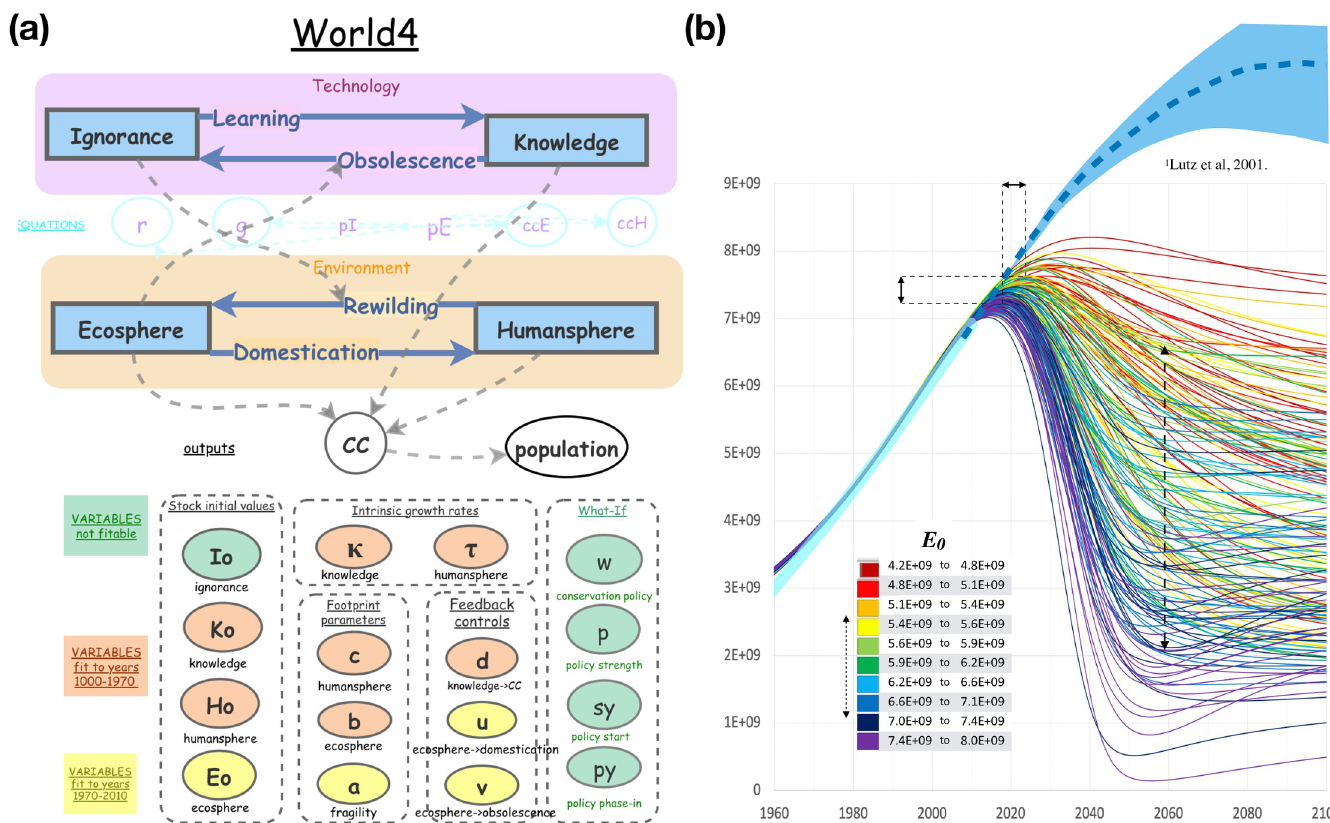
Fig 1. (a) World4, a system dynamics model that reproduces world population numbers up to 2010 and projects forward. Stocks (rectangles) and flows (solid arrows) form two interacting closed systems, one for Technology and one for Environment. Input variables (ovals) are colored and grouped by function. Output variables (white) are the global carrying capacity ( CC ) and population . Dashed lines indicate variable dependencies. (b) World4 simulations superposed on 20th century population numbers (thick cyan line) and UN population projections [11] (dashed blue line is the median projection and light blue are 95% confidence region). The program hyperfit carried out 1 million World4 simulations using randomly selected parameters from ranges listed in Table 1. Shown are the 184 trajectories that deviate value (total ecosystem size in gha , see inset). Counterintuitively, a low E from 1970–2010 population data by less than rms 0.5e8. Simulations are colored by their E 0 0 means a higher population is sustainable. Double-headed arrows indicate 80% confidence ranges for peak date, peak height and 2060 population.